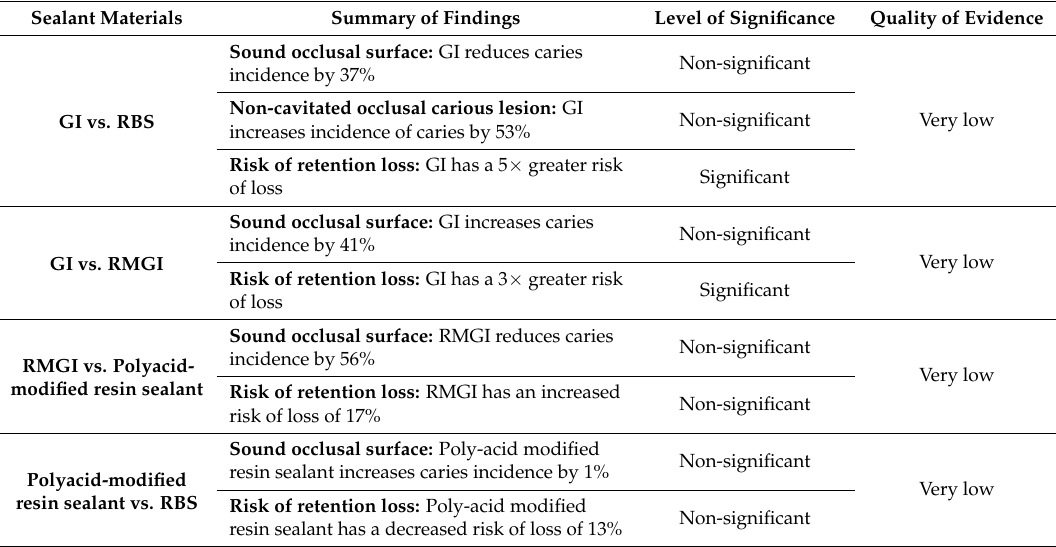
Table 2. Summary of evidence-based findings when comparing different sealant